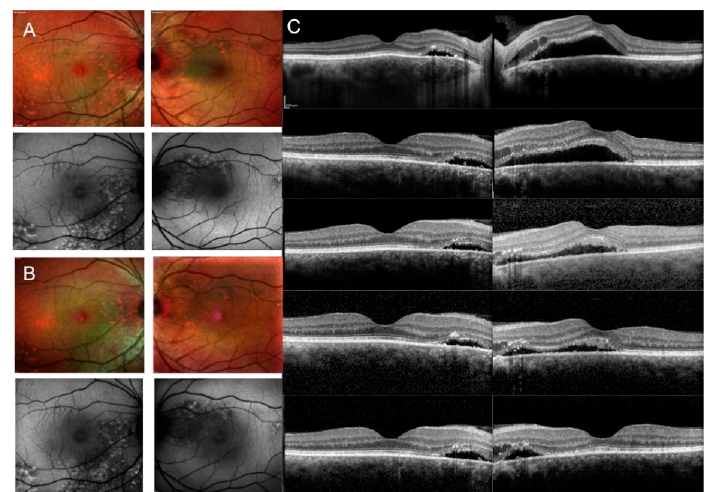
Figure 1. Multimodal imaging of patients with chronic central serous chorioretinopathy (CCSC) at baseline and during a 4-month follow-up during eplerenone treatment. Multicolor fundus image (MFI) (first row) and fundus autofluorescence (FAF) (second row) of right and left eye images showing widespread retinal pigment epithelium (RPE) atrophy in both eyes and foveal subretinal fluid (SRF) in left eye at baseline ( A ); MFI and FAF of both eyes after SRF resolution at 4 months ( B ); spectral domain optical coherence tomography (SD OCT) of right and left eye showing extrafoveal SRF in right eye and foveal SRF and extrafoveal intraretinal fluid in left eye at baseline (first row) and foveal SRF resolution during follow-up in left eye (30 days, second row; 60 days, third row; 90 and 120 days, fourth and fifth rows, respectively) ( C ).